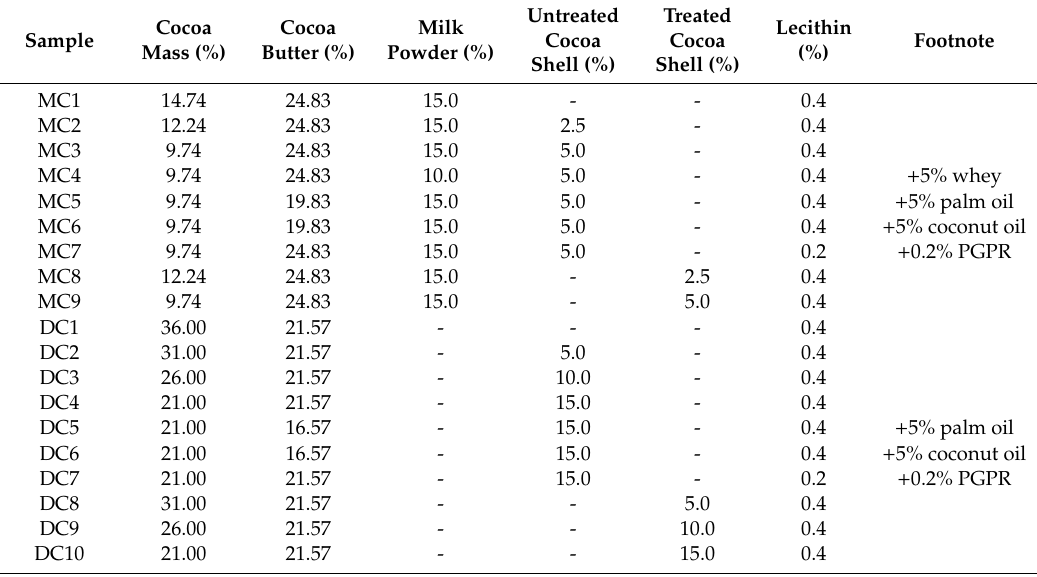
Table 3. Composition of chocolate